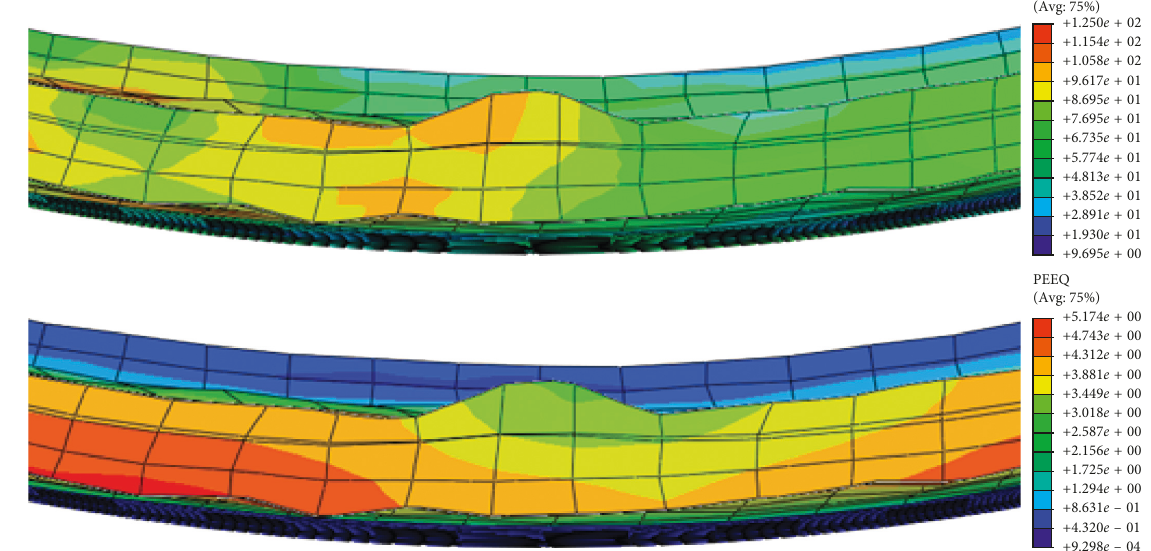
Figure 8: Mises stress diagram and equivalent strain diagram of the longitudinal ribs ( α � 17 ° , Ψ � 43%, and f � 120mm/min). S, Mises (Avg: 75%)